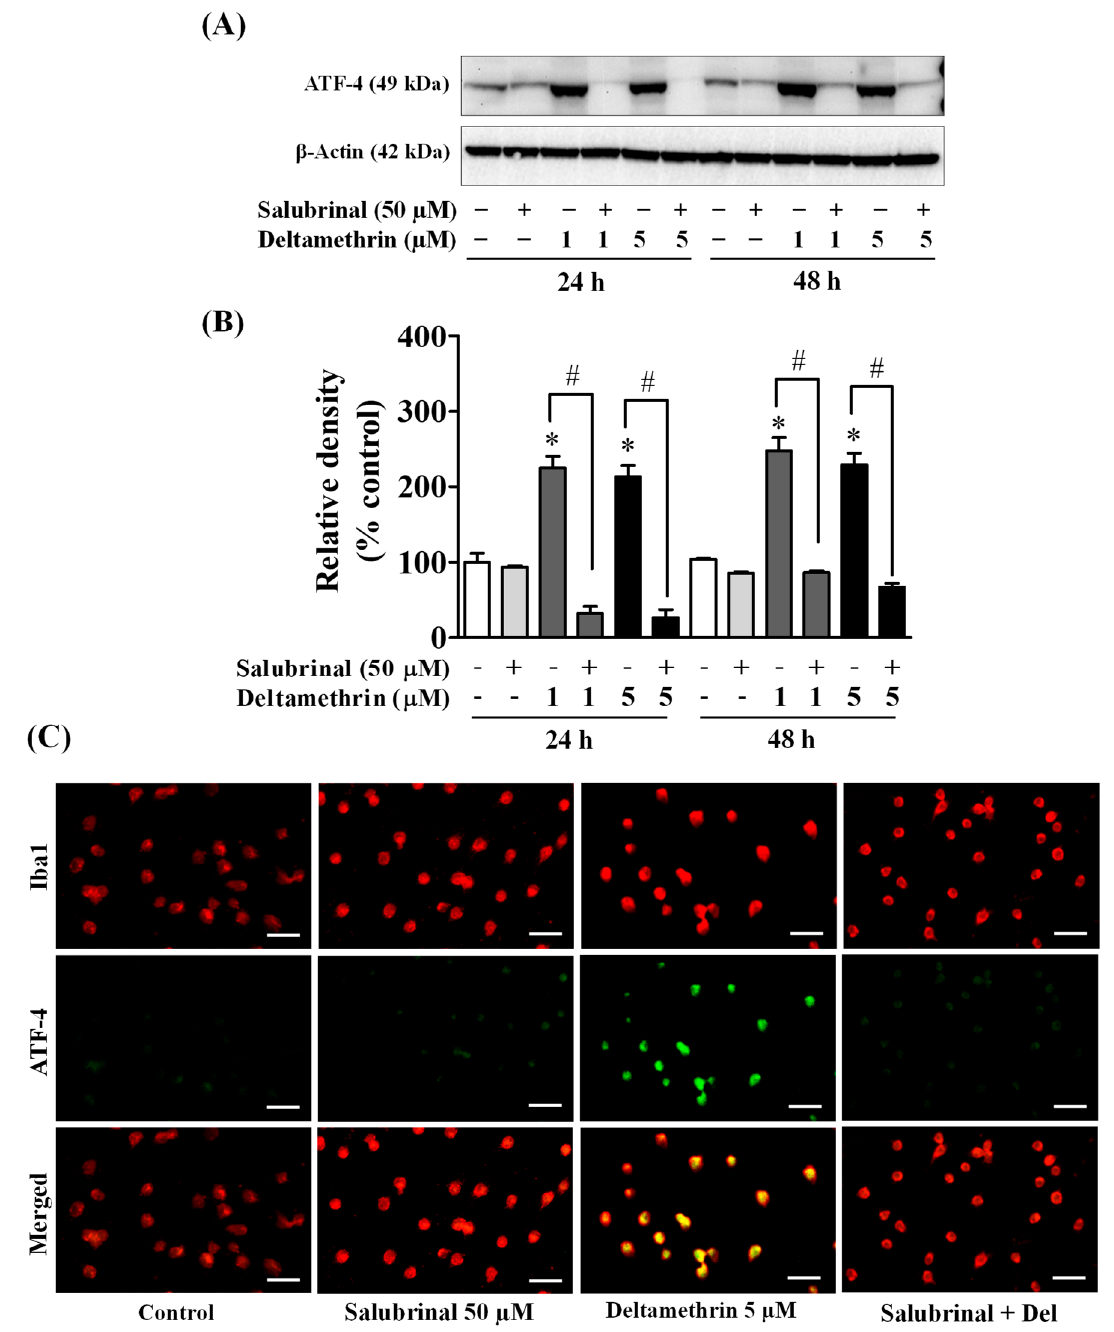
Figure 7. Salubrinal prevents deltamethrin-induced increased levels of ATF-4 in MMCs. Protein levels of ATF-4 in MMCs were quantified by densitometry from Western blots ( A ). The results are reported as relative band densities from representative blots in bar graphs ( B ). The values represent mean ± SEM from three independent experiments, each of which was performed in triplicate. An asterisk denotes significant difference from the control group, and a hashtag denotes significant differences between deltamethrin and deltamethrin + salubrinal ( p < 0.05). Expression of ATF-4 protein in MMCs was visualized by immunofluorescence staining ( C ). MMCs were labeled with anti-Iba1 antibody (red). ATF-4 protein was visualized by immunolabeling (green). Co-localization of ATF-4 and Iba1 is shown in yellow. Scale bar = 200 µm.